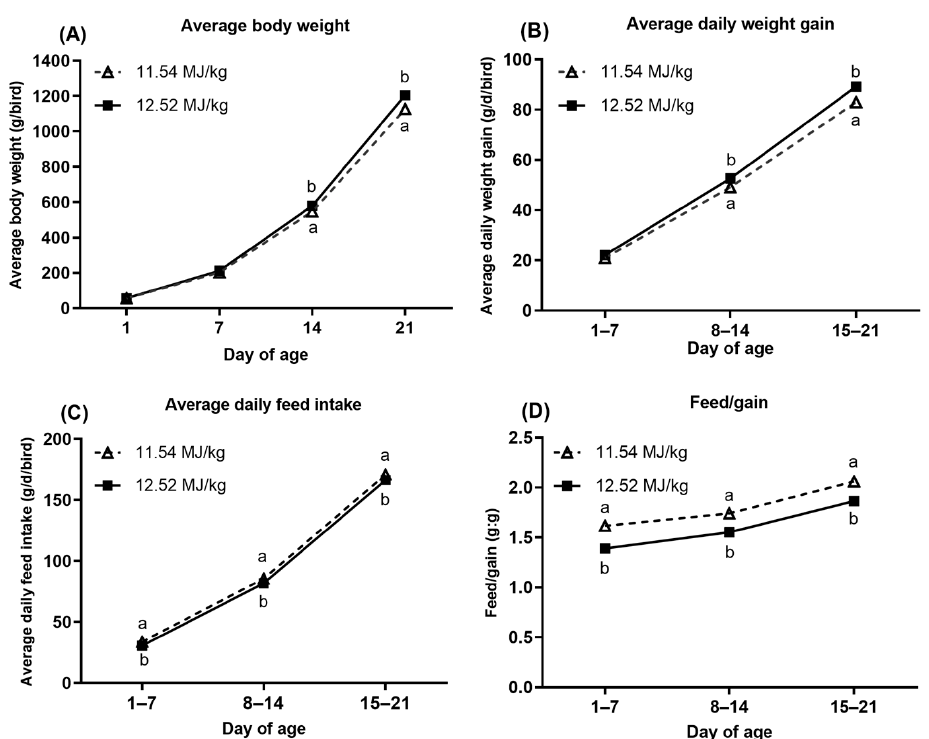
Figure 1. Effect of dietary energy concentration on growth performance of starter Pekin ducks (1 to 7, 8 to 14, 15 to 21 days of age). ( A ): Average body weight; ( B ): average daily weight gain; ( C ): average daily feed intake; ( D ): feed/gain. a,b Means within the same day of age with different superscripts are significantly different ( p < 0.05). The results were obtained from data of main effect (metabolizable energy, ME) by two-way ANOVA analysis. SEM = 0.12, 3.23, 5.40, and 7.52 for 1, 7, 14, and 21 day body weight, SEM = 0.46, 0.45, and 0.51 for average daily weight gain of 1 to 7, 8 to 14, and 15 to 21 days of age, SEM = 0.56, 0.88, and 1.46 for average daily feed intake of 1 to 7, 8 to 14, and 15 to 21 days of age, SEM = 0.015, 0.010, and 0.012 for feed to gain ratio of 1 to 7, 8 to 14, and 15 to 21 days of age.